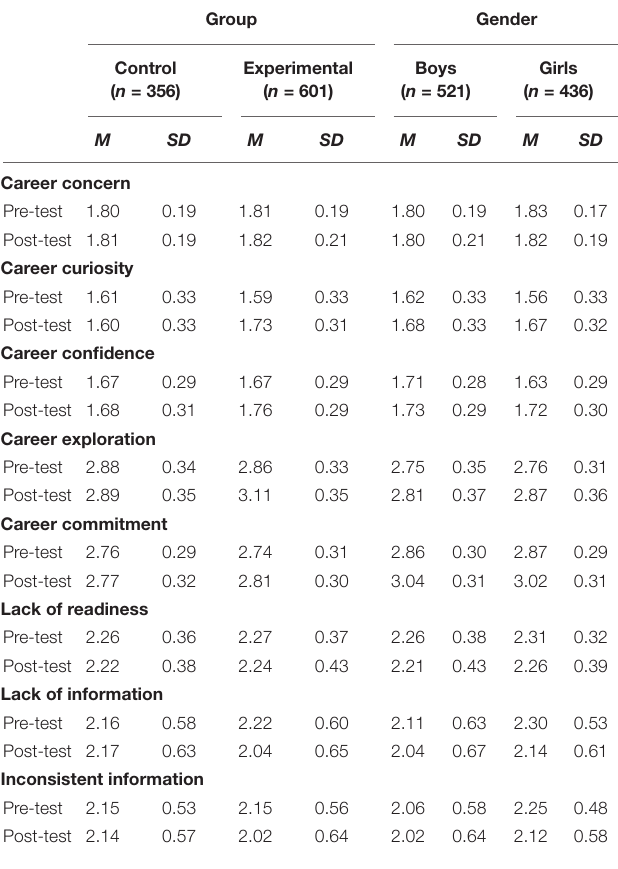
TABLE 1 | Means and standard deviation among the study